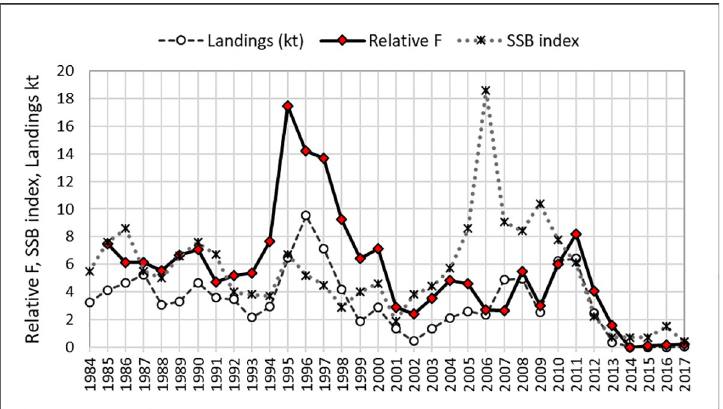
Fig 11. Northern shrimp biomass-weighted relative F, landings (kt), and spawning stock biomass index. Spawning stock biomass (SSB) index (based on summer offshore surveys) and landings data are from [34].